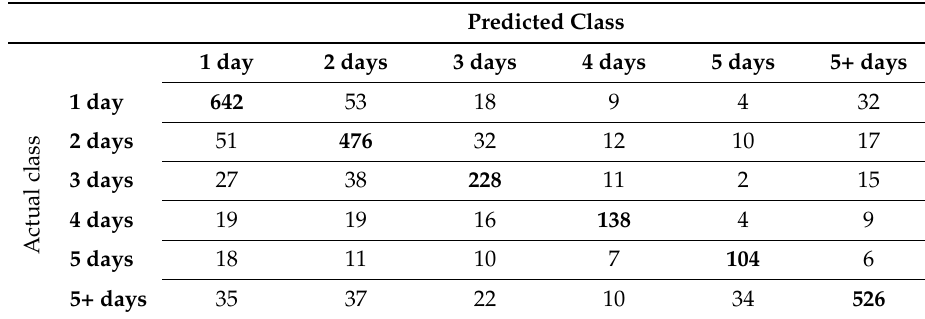
Table 9. Confusion matrix of two-level classifier.